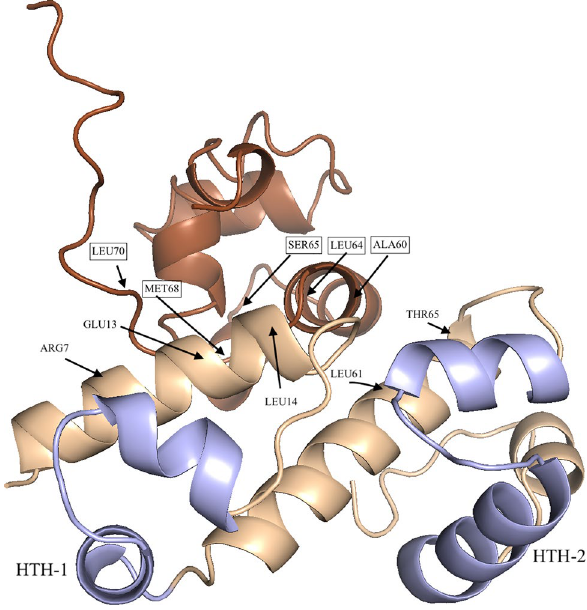
Figure 5. Proposed contacts between PerA and RpoA. A docking model for PerA-CTD and RpoA-CTD was generated the CPHmodels 3.2 server (http:// www. cbs. dtu. dk/ servi ces/ CPHmo dels) using the E. coli transcriptional factor Rob (PDB entry 1D5Y chain A) as a template. Stereochemical quality of the model was assessed by using the Ramachandran plot at RAMPAGE program SAVES v6.0 (https:// saves. mbi. ucla. edu/). The C-terminal domain of the RNAP α-subunit (PDB entry 1COO) was used to model the interaction with PerA with the HawkDock program (http:// cadd. zju. edu. cn/ hawkd ock). PerA-CTD is shown in gold and purple and RpoA-CTD (CTD-α) in brown. Putative interacting residues are labeled as follows: RpoA residues are shown in boxes while those from PerA-CTD are not in boxes. PerA HTHs are